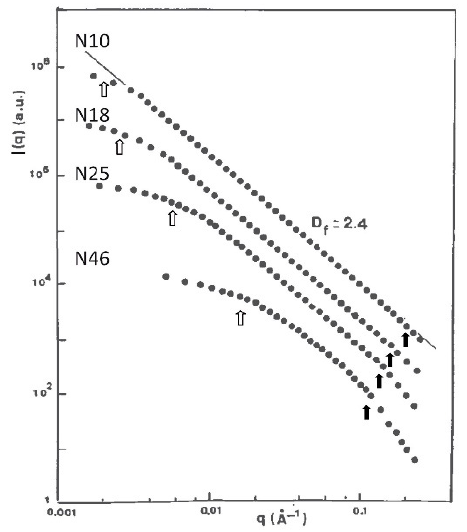
Figure 3. I(q) as measured by SANS for the neutral set (from [32]).